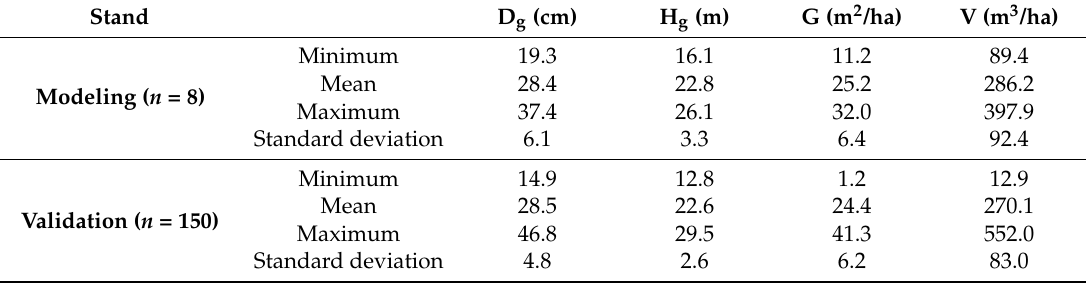
Table 1. Variation in basal-area weighted mean diameter (D g ), basal-area weighted mean height (H g ), basal area (G), and stem volume (V) in modeling and validation stands based on harvester data.